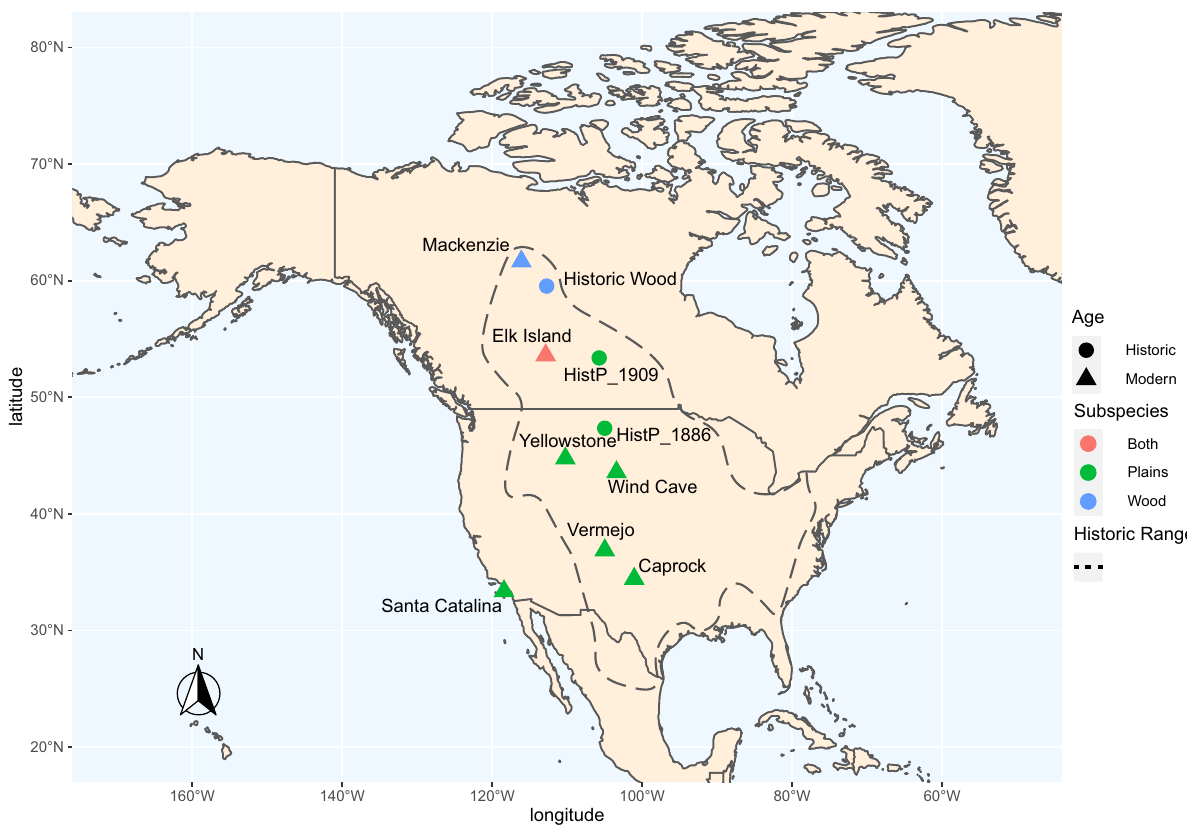
Figure 2. Map of sampled bison populations. Color-coded by subspecies (Plains or Wood). Shapes are used to differentiate historic (before 1940) and modern (after 1990) samples. The dotted line estimates the historic range of bison in North America 12 . Image generated in R v4 using bisonmap.R script at github.com/agaricx/